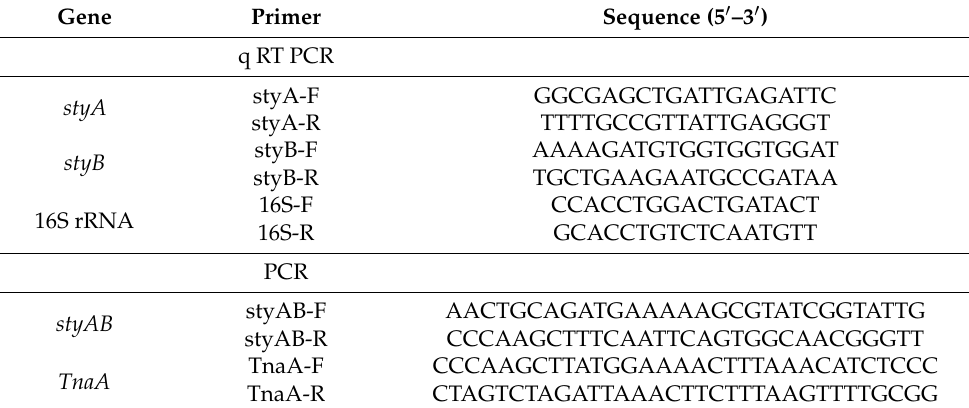
Table 2. Primers used in this